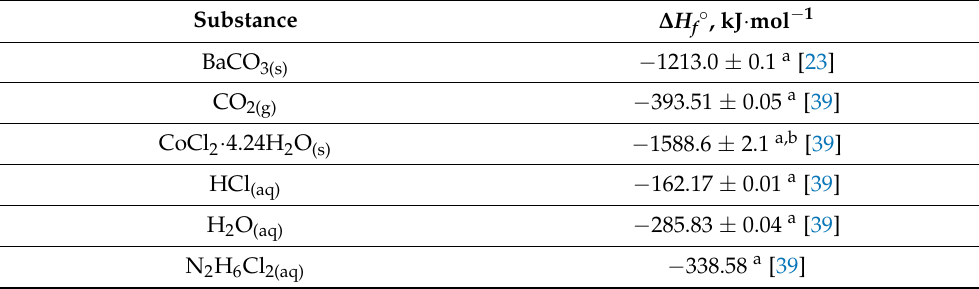
Table 5. Standard enthalpies of formation at 298.15 K, ∆ H f ◦ , used for calculating ∆ H f ◦